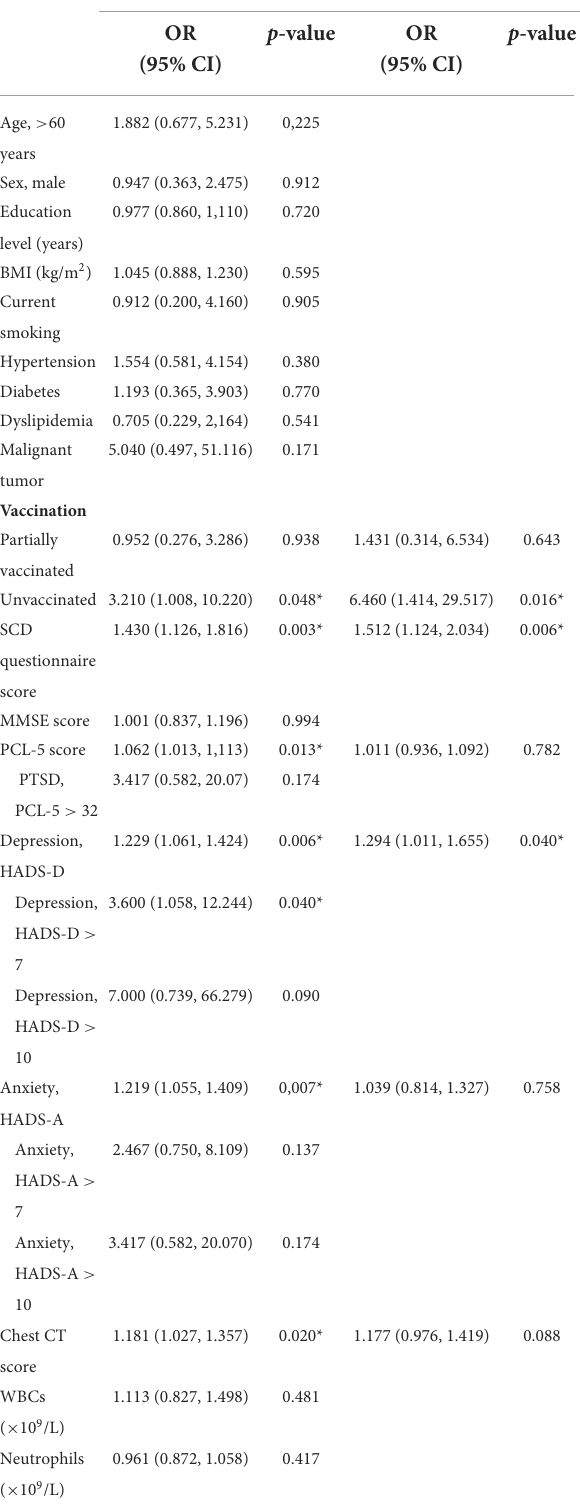
TABLE 4 Univariate and multivariate analyses of risk factors for impaired quality of life. Univariate